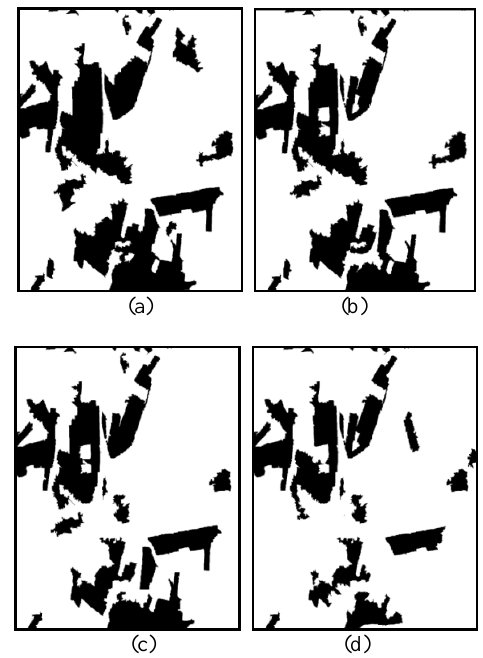
Figure 9. Change detection results of different weight distribution, (a) a=0.6, b=0.4, (b) a=0.7, b=0.3, (c) a=0.8, b=0.2, (d) a=0.9, b=0.1